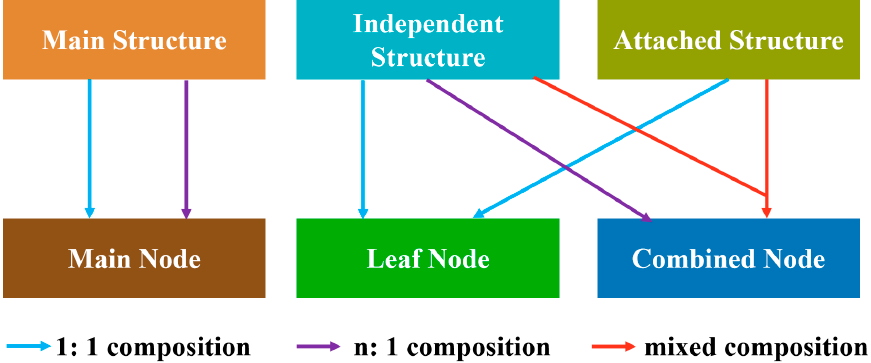
Figure 7. All generation paths from structure to transmission node. Figure 8 delineates the extraction results for various transmission nodes. Since the hole triangle nodes are covered by the other nodes, they are not shown in Figure 8.